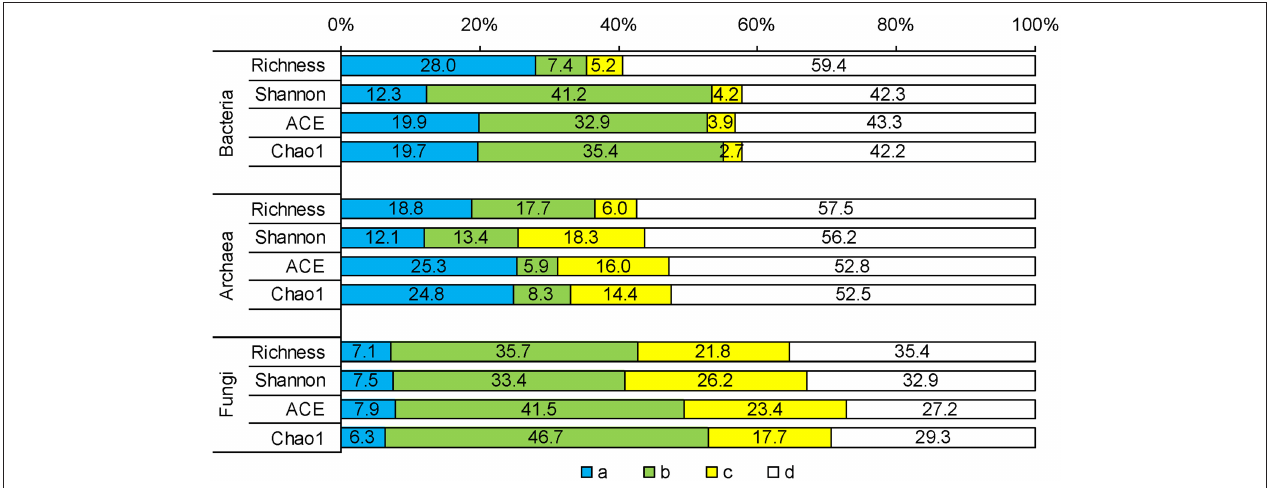
FIGURE 2 | Comparisons between effects of vegetation and the effects of soil properties on microbial diversity indices by partial regressions. The variation of microbial diversity indices is partitioned into (a) the independent components of plant and (c) soil properties, (b) the covarying component and (d) residual variation.